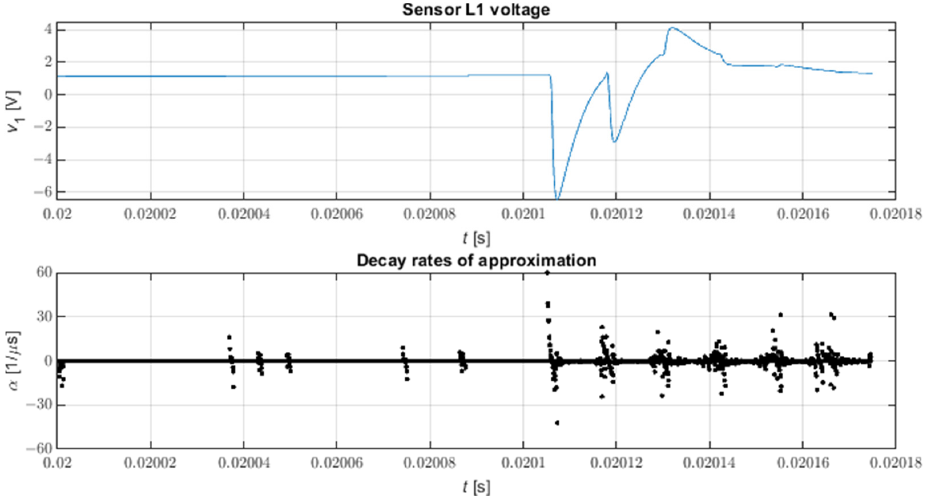
Figure 9. All decay rates of STMPM approximation. N = 9, L = 4.